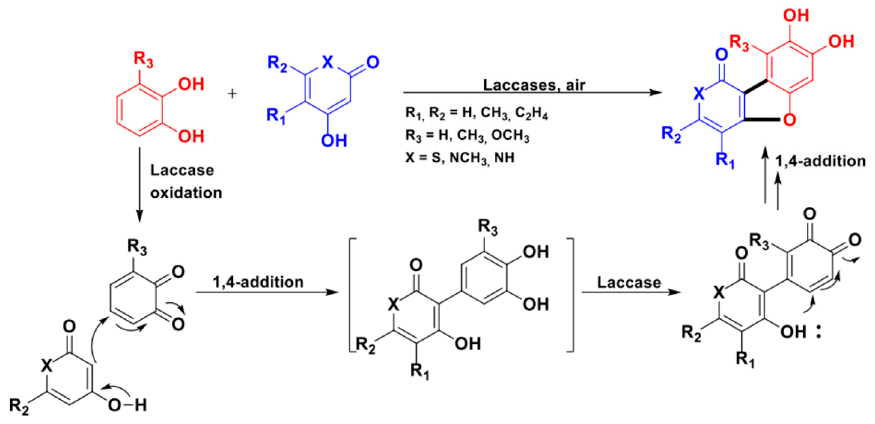
Figure 2. Example of oxygenated heterocycles obtained by Beifuss and coworkers [125–128]. Beifuss’ investigation was also expanded to the preparation of sulphurated and ni- trogenous poly(hetero)cycles by the clever exploitation of S - and N -containing synthetic equivalents of 1,3-dicarbonyls. Their elegant biocatalytic entry to pyrimidinyl benzothia- zoles, which was based on the use of 2-thioxo pyrimidine as nucleophiles, is presented in Scheme 33 [28]. Target products were obtained as enriched mixtures of regioisomers.